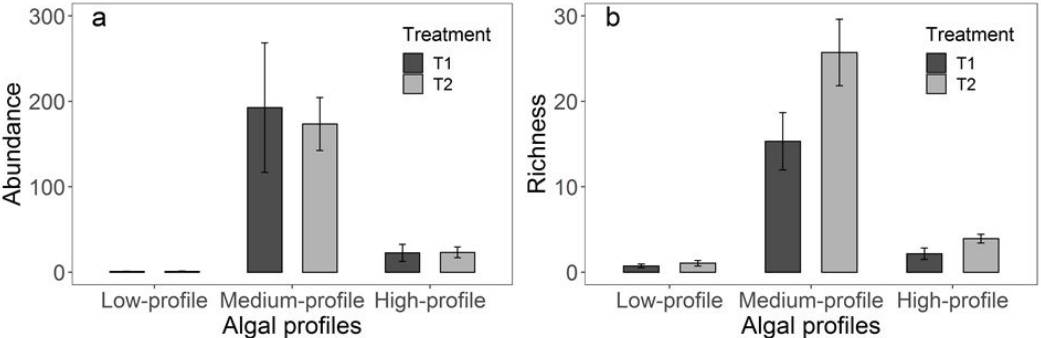
Figure 4. Mean and standard error of the abundance (a) and species richness (b) of periphytic algal profiles from the food content of Moenkhausia sanctaefilomenae at treatments T1 (without zooplankton) and T2 (with zooplankton). Table 1. Analyses of deviance table (Type II) of fixed effects of treatments (without and with zooplankton) and periphytic algal profile (low, medium and high) on the abundance and richness of algae. Treatment Algal profile Treatment * Algal profile Abundance